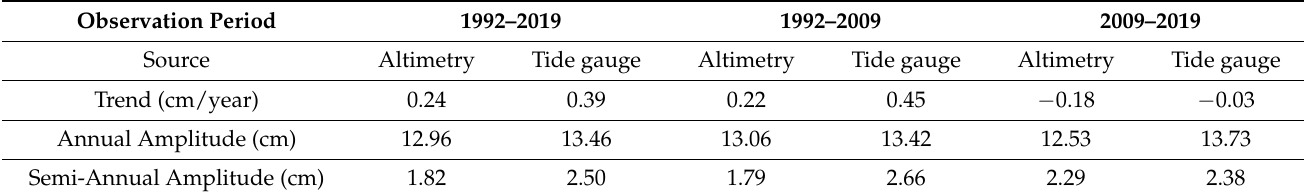
Table 1. Sea level trend over the period of